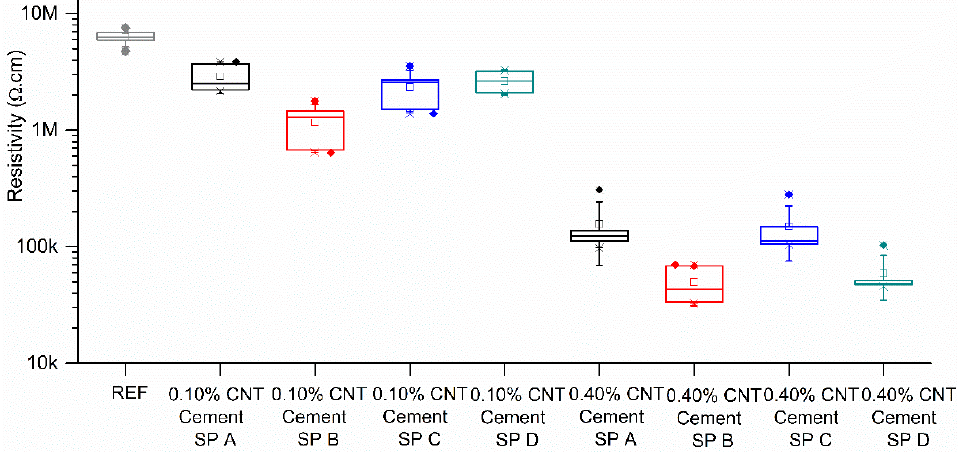
Figure 10. Electrical resistivity results for CNT–cement composites in partially dry condition (boxes presenting 25, 50, and 75% percentile, whiskers presenting one standard deviation, and solid symbols presenting outliers).